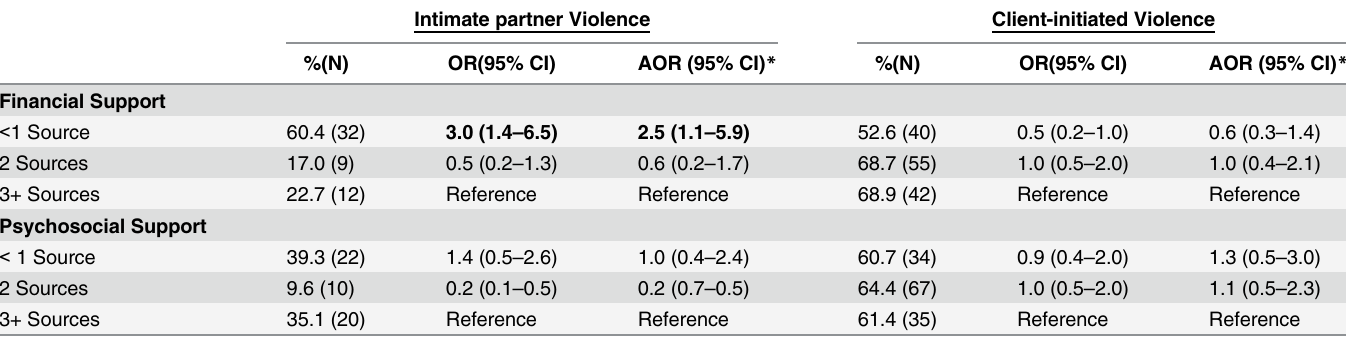
Table 3. Multi-variable regression of client-based and intimate-partner violence by social support network size among female street-based sex workers in Shanghai, China from 2011 – 2012 (N =